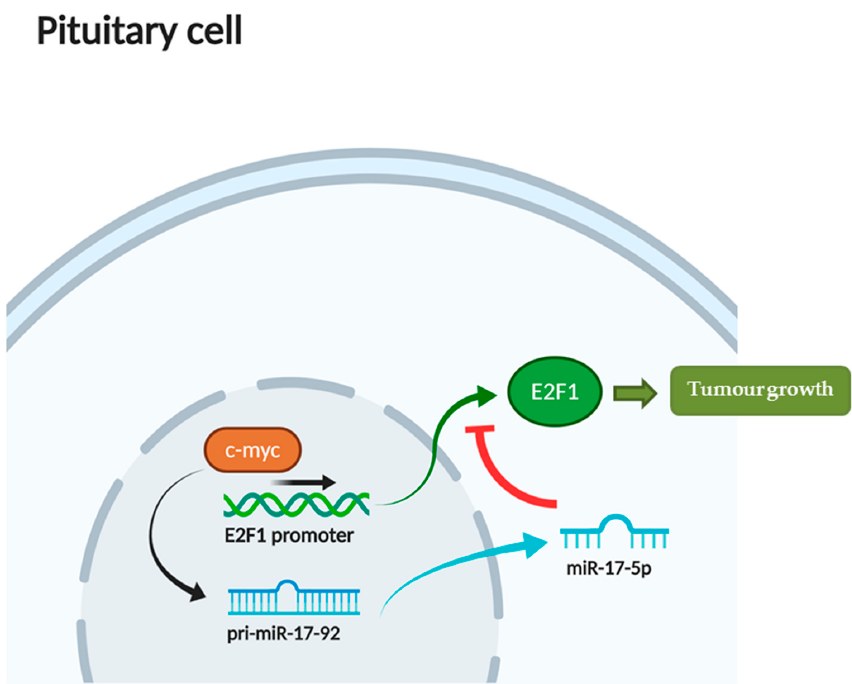
Figure 5. Participation of mature miR-17-5p in the regulation of MYC and E2F1 networks in PitNETs.